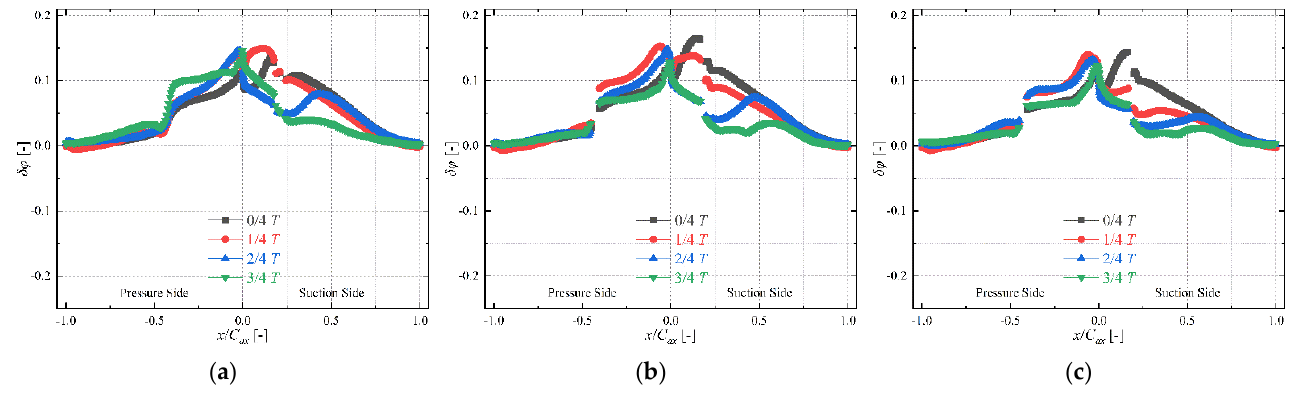
Figure 16. The increment in overall cooling effectiveness distribution along the blade surface. ( a ) At 25% span; ( b ) at 50% span; ( c ) at 75% span.